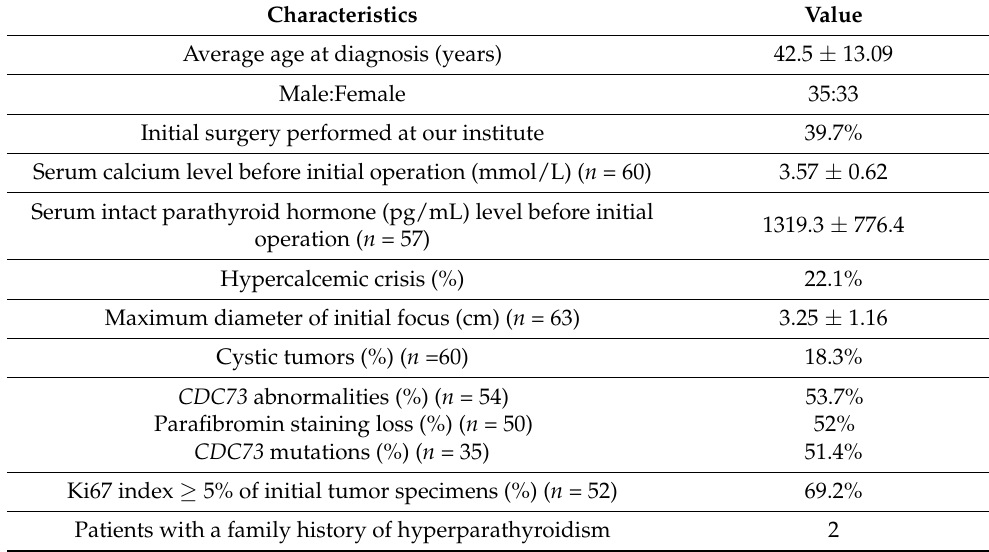
Table 1. Clinical characteristics of patients with parathyroid carcinoma ( n = 68 unless otherwise